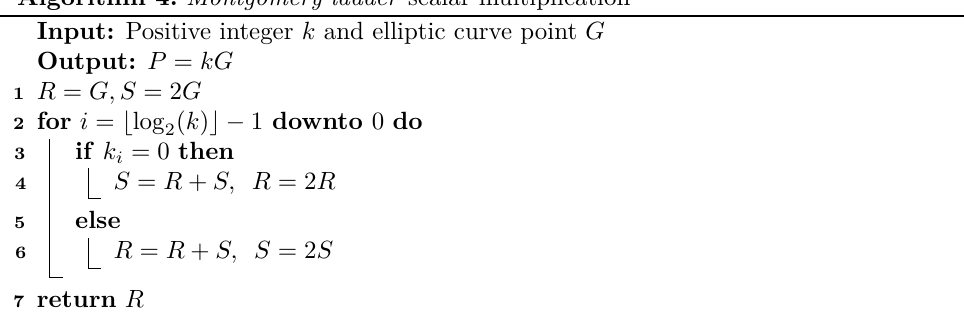
Algorithm 4: Montgomery ladder scalar